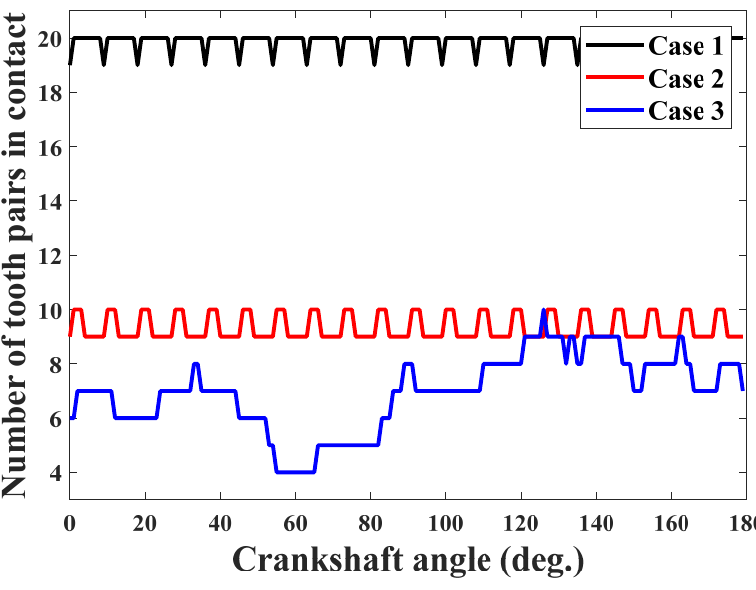
Figure 16. Comparisons of the number of tooth pairs in contact for three cases.